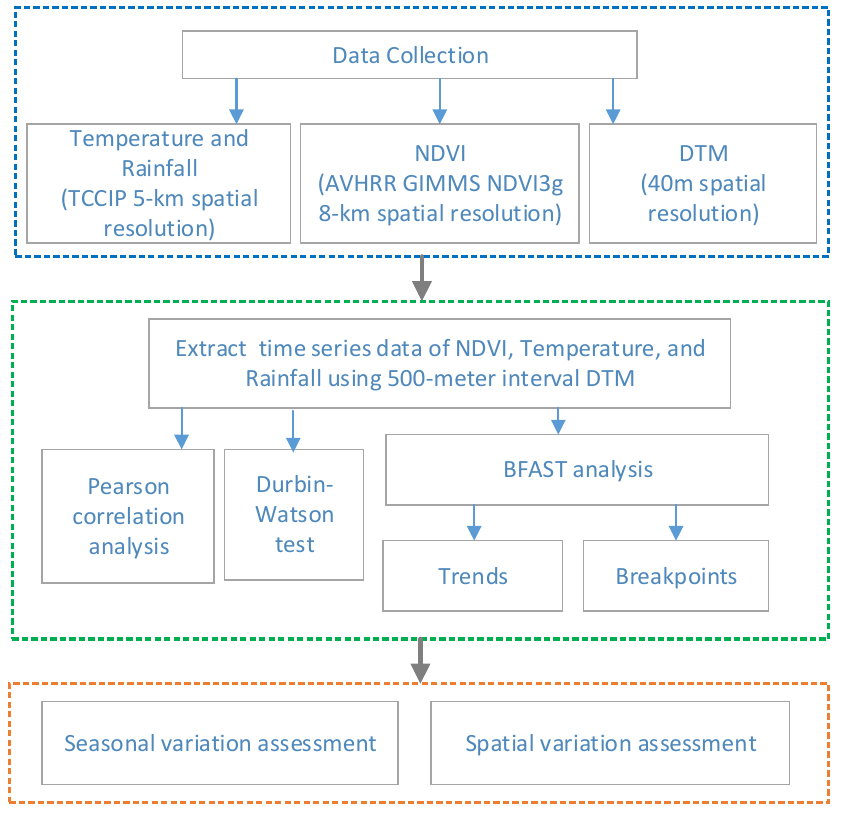
Figure 2. Research flow .